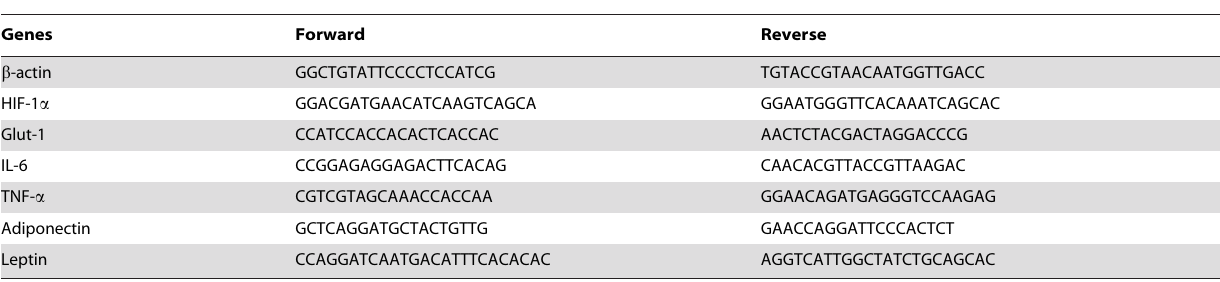
Table 1. The primer sets used for real-time